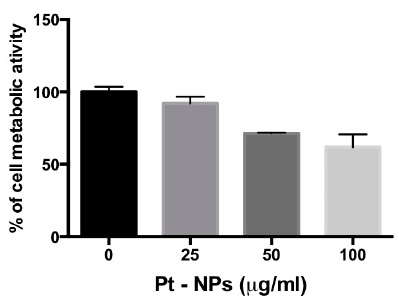
Figure 5. Metabolic activity of pre-differentiated THP-1 treated with different concentrations of PtNPs for 24 h. All the data represent the mean ± SD of three independent experiments.